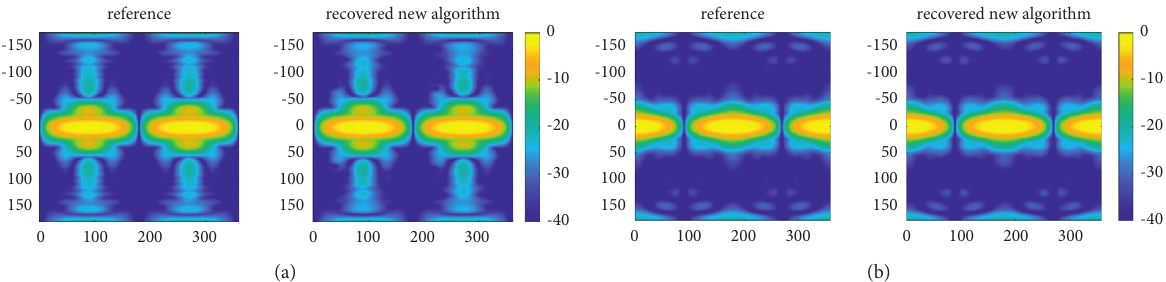
Figure 21: The reconstructed E